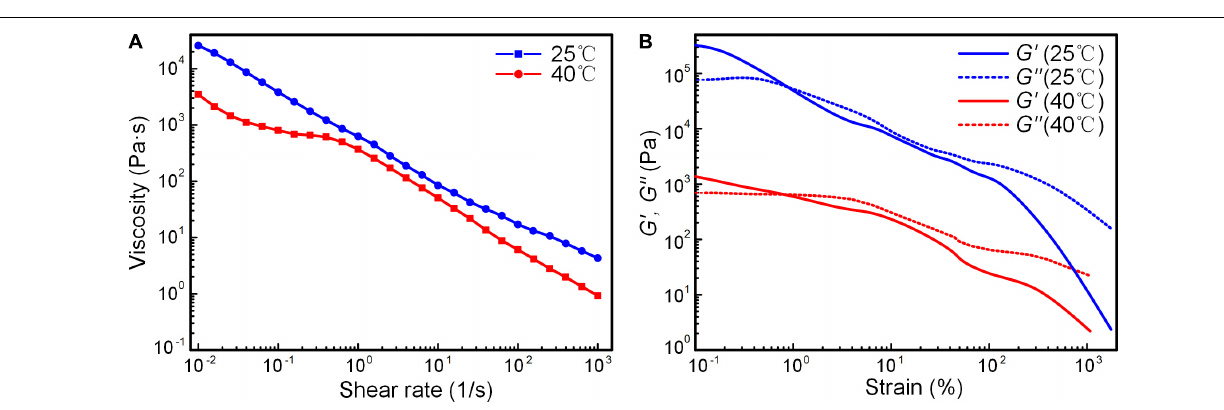
FIGURE 2 | Rheological properties of the PU elastomer under 25 and 40 ◦ C. (A) Apparent viscosity as functions of shear rates for inks with different temperature. (B) Storage and loss moduli as functions of shear strain with different